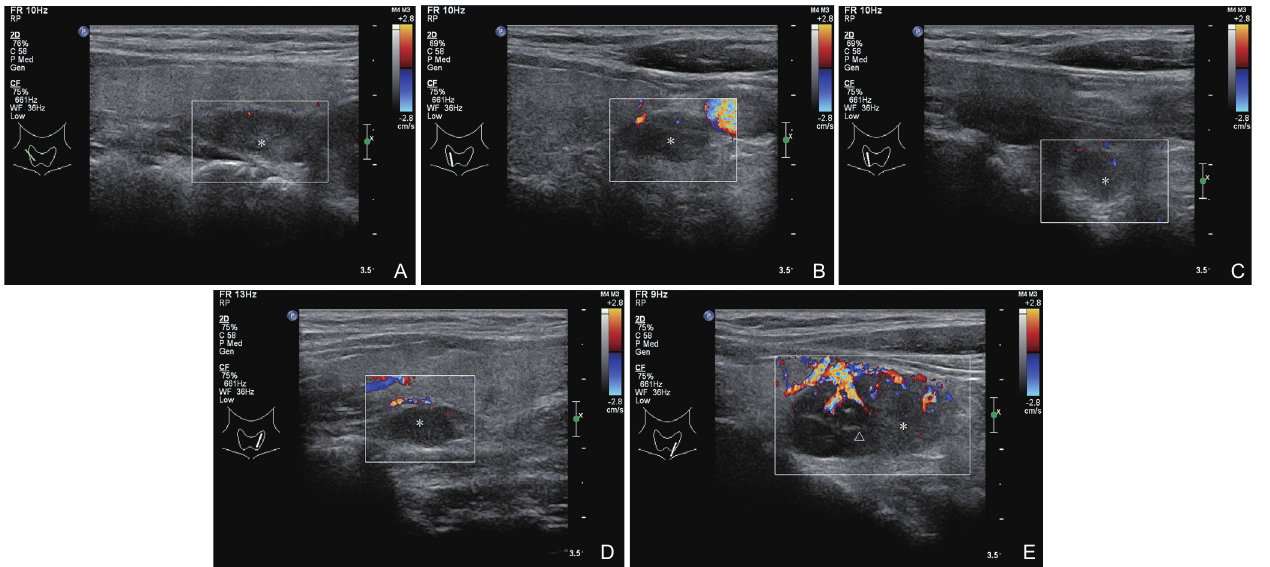
Figure 1 Sonographic images of PTGs in a 31 years old female patient in the hypo-vascular subgroup. There were five detectable PTGs, in which most of them (4/5) were hypo-vascular feature. (A). Longitudinal image of the gland in a right superior position (*), the gland was slightly heterogeneous, appearing to be partial hypoechoic and partial hyperechoic. The Doppler score Onoda was P1, C0; (B). Longitudinal image of the gland in the right inferior position (*), appearing to be hypoechoic with Doppler score Onoda P1, C0; (C). Longitudinal image of a supernumerary PTG in the right inferior position. This “newborn” echoic gland (*) was with Doppler score Onoda P1, C0; (D). Longitudinal image of a gland in a left superior position (*), appearing to be hypoechoic with the Doppler score Onoda P2, C0; (E). Longitudinal image of a gland in the left inferior position, appearing to be highly heterogeneous with partial hyperechoic ( △ ) and partial hypoechoic. The Doppler score Onoda was P2,